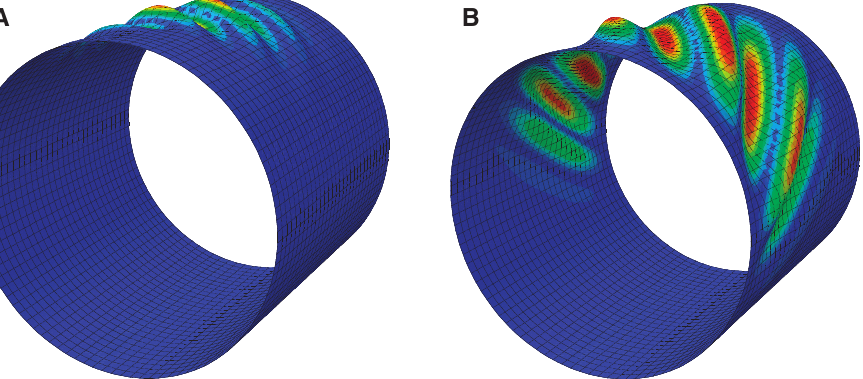
Figure 10: The buckling mode of the composite cylinder with (A) QI and (B) VS laminate with 100% of layers considered for fiber steering (case